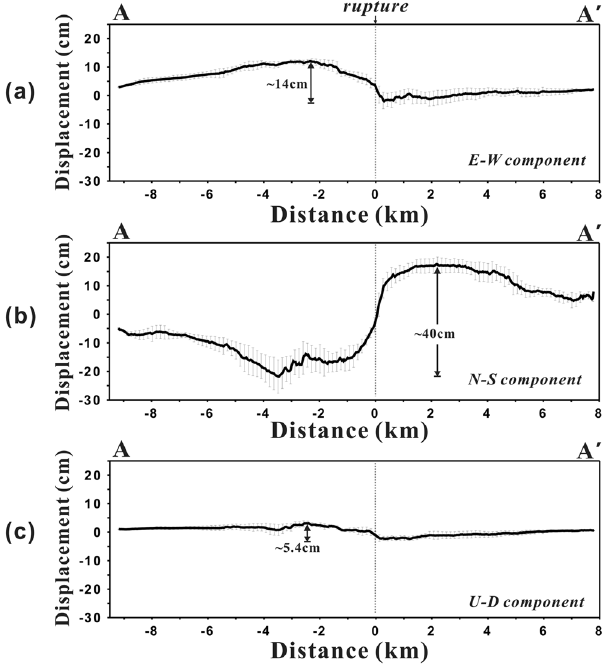
Figure 5. Surface displacements of ( a ) east, ( b ) north, and ( c ) up components along profile A-A’ across the surface rupture shown in Fig.